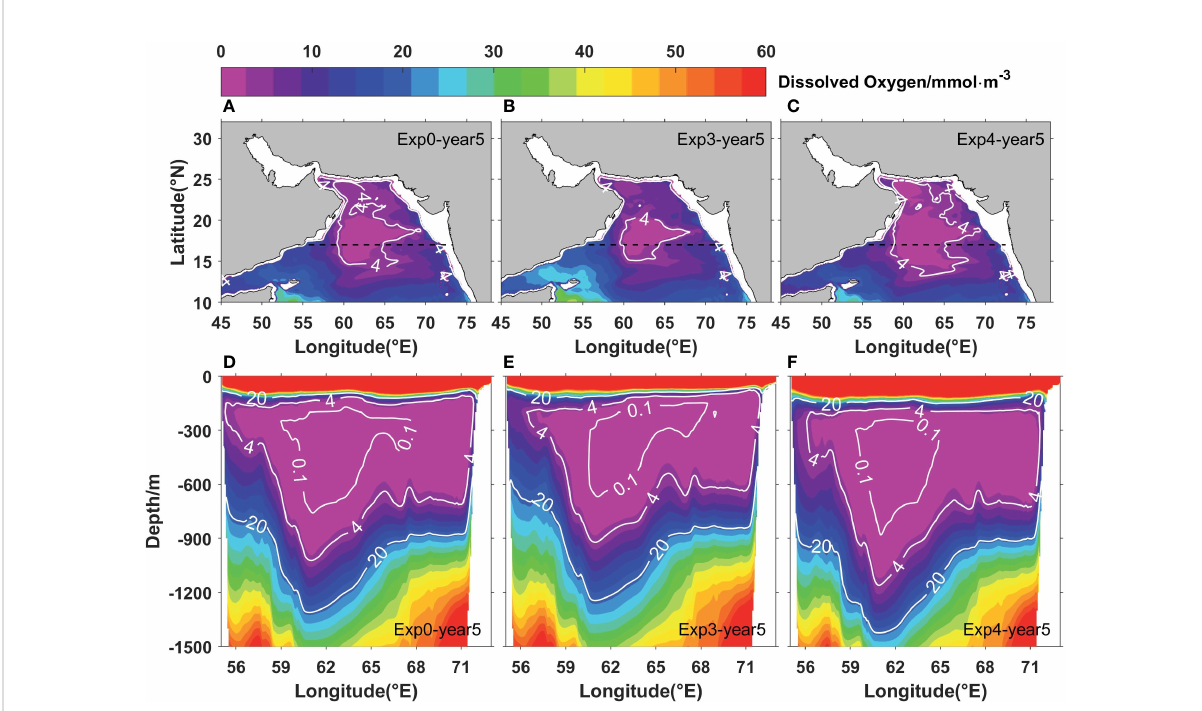
FIGURE 10 Annual mean horizontal distributions of dissolved oxygen (A – C) averaged between 200 and 1,000 m and vertical distributions of dissolved oxygen (D – F) in the upper 1,500 m at 17°N from three experiments (Exp0, Exp3, and Exp4) after 5 years of